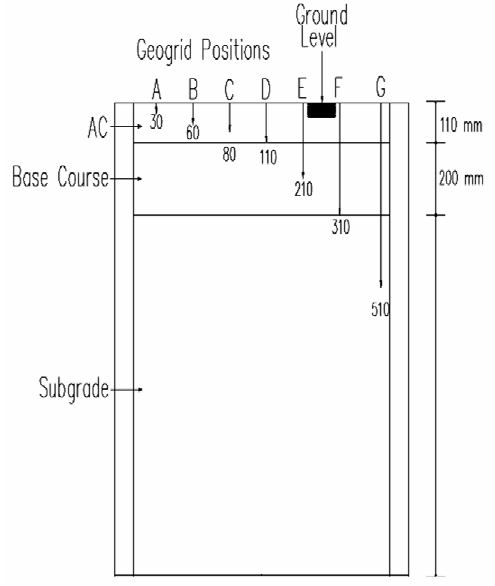
Figure 4. Representation of geo-grid position depth. AC: Asphalt Concrete.